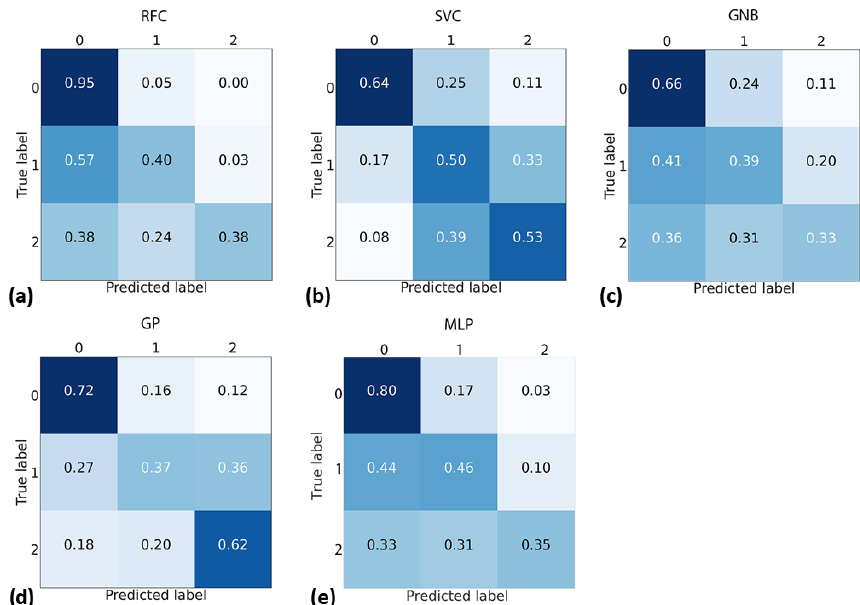
Figure 6. Confusion matrices produced using the randomly selected national dataset and (a) RFC, (b) SVC, (c) GNB, (d) GP and (e) MLP. Each cell of the confusion matrices represents a share of predictions having a corresponding combination of predicted and true class. For example, the middle right cell tells the share of samples belonging to class 1 but predicted to have class 2.